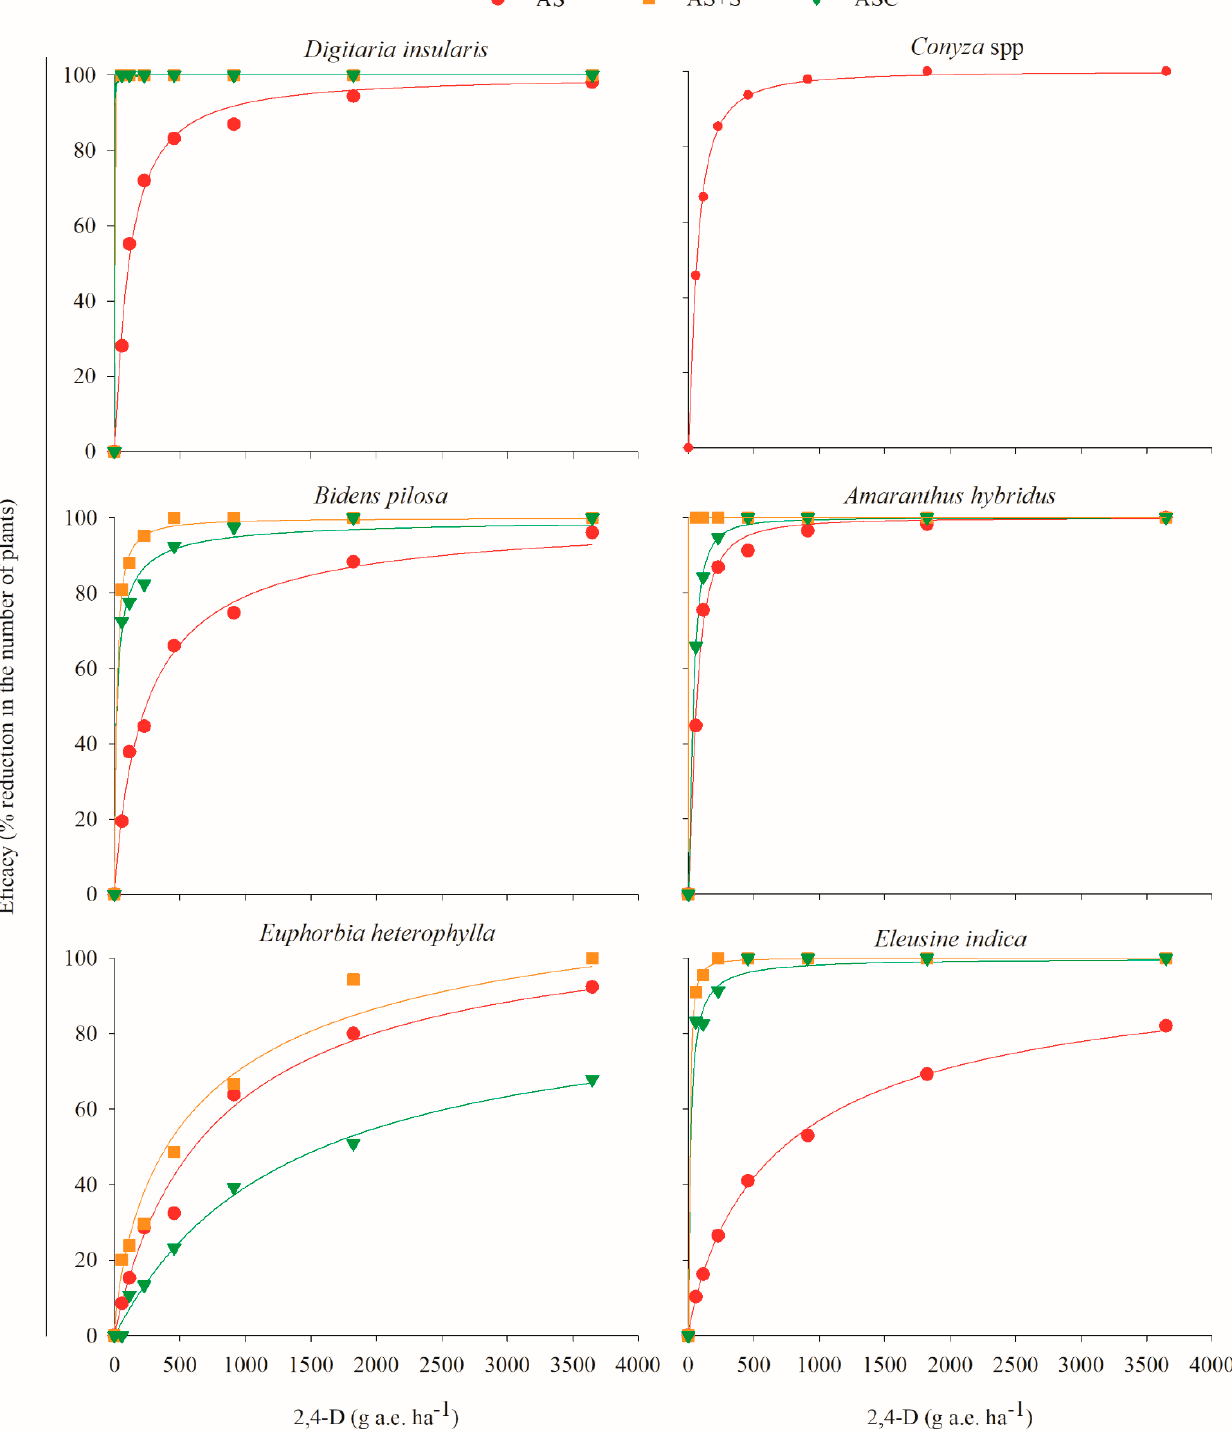
Figure 3. Efficacy of 2,4-D choline salt in the pre-emergence of Digitaria insularis, Conyza spp., Bidens pilosa, Amaranthus hybridus, Euphorbia heterophylla, and Eleusine indica as a function of the application method. AS = application directly on the soil without subsequent straw cover; AS + S = application on the soil followed by straw cover; ASC = application on the straw covering the soil. All were followed by a simulation of 10 mm of rain. The data are expressed as the percentage of the reduction in the number of plants in relation to the treatment with no herbicide applied for each application type.